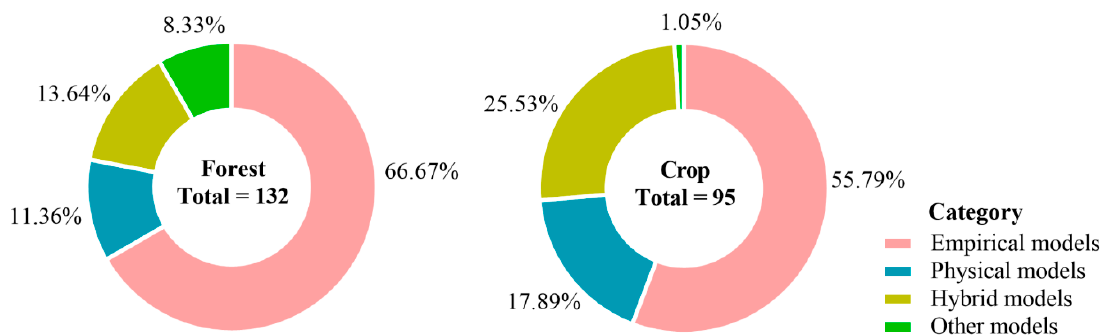
Figure 2. Distribution of different model types for forest (left) and crop (right) LAI estimation.